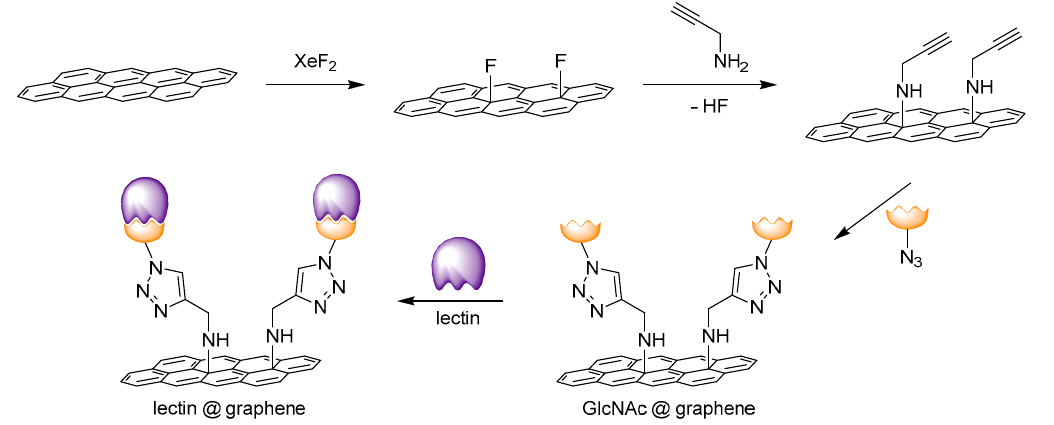
Figure 1. Scheme of the graphene chemical functionalization with chitooligomers for WGA binding. In the first step, pristine graphene was fluorinated, followed by nucleophilic exchange with propargyl amine. Using the CuAAC click reaction, azidoethyl-substituted chitooligomers (GlcNAc) 1–5 were grafted on the functionalized graphene. WGA lectin binds to chitooligomer ligands immobilized on the graphene surface.